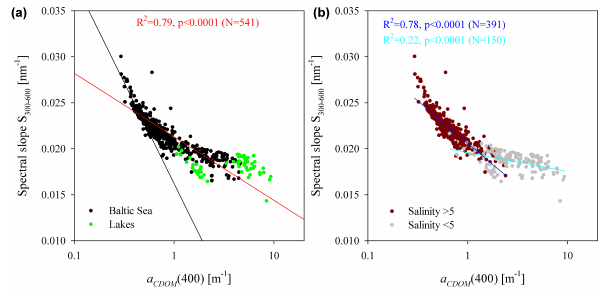
Figure 2. Relationship between the spectral slope S 300–600 and the coefficient of light absorption by CDOM for a wavelength of 400nm, a CDOM (400), in the semi-log scale: (a) in the Baltic (black dots) and lakes (green dots) – the black curve is the approxima- tion obtained by Kowalczuk (2001) and the red line represents the approximation given by Eq. (10); (b) for samples with salinity>5 (most of the seawater samples) and with salinity<5 (samples from lakes, river mouths, the Szczecin Lagoon) – the blue line represents the approximation given by Eq. (11) and the cyan line the approxi- mation given by Eq.